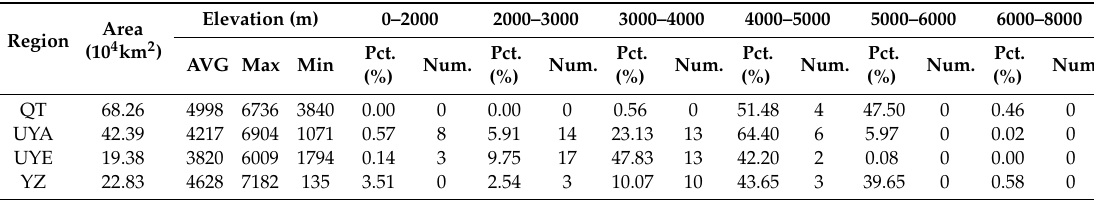
Table 4. Station distribution along the elevation in the four basins. The Pct. shows the area within the elevation range as a percentage of the entire basin area, and the Num. column shows the number of the meteorological stations located within the elevation